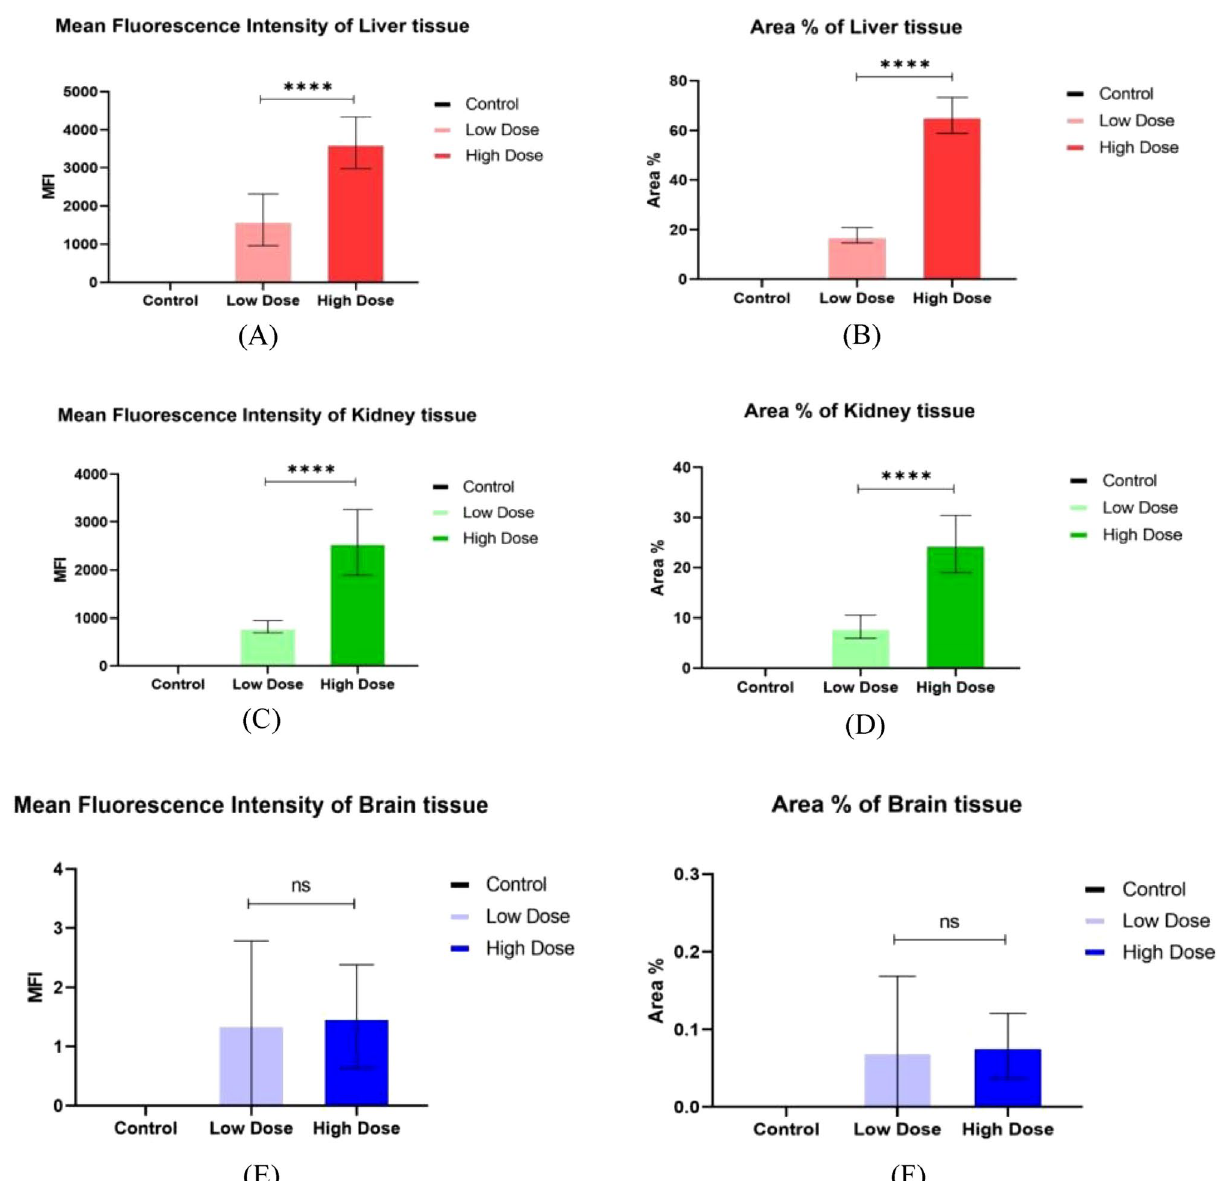
significance *p ≤ 0.05, **p ≤ 0.01, ***p ≤ 0.001, ****p ≤